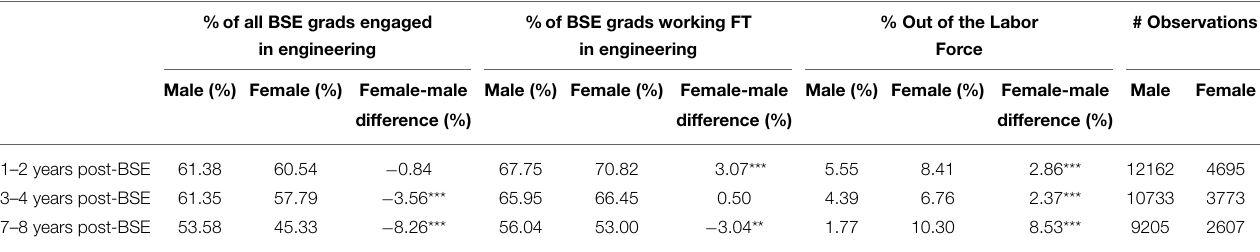
TABLE 1 | Average probability of remaining in engineering (working or studying) or out of the labor force: all cohorts combined. %of all BSE grads engaged